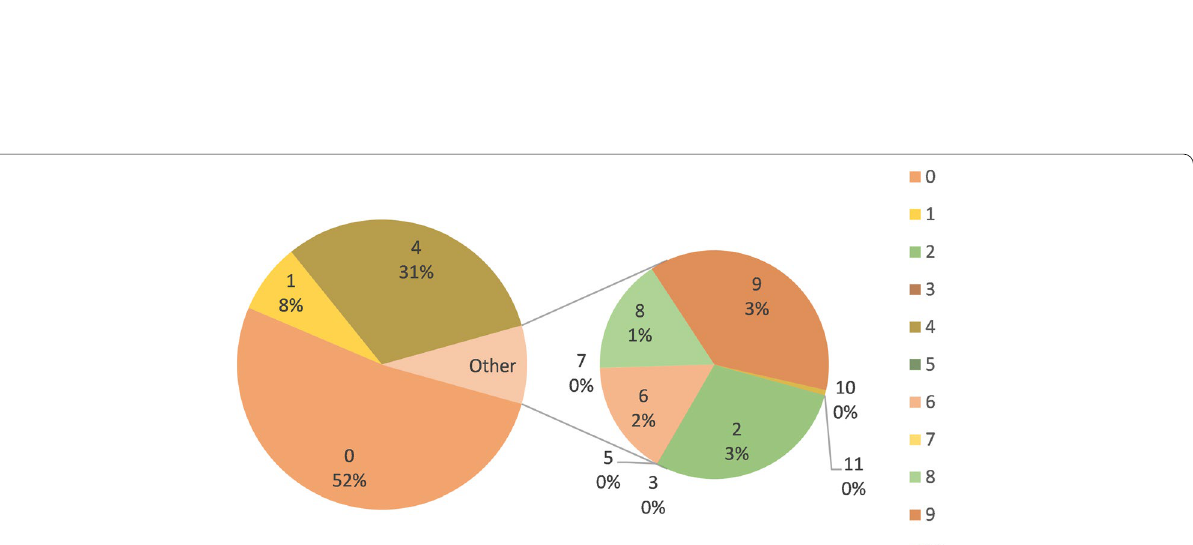
Fig. 6 The figure shows the distribution of task priority in the task event table. The left chart depicts the overall distribution of task priority, whereas the right chart depicts a detailed distribution of job priority, that is smaller than